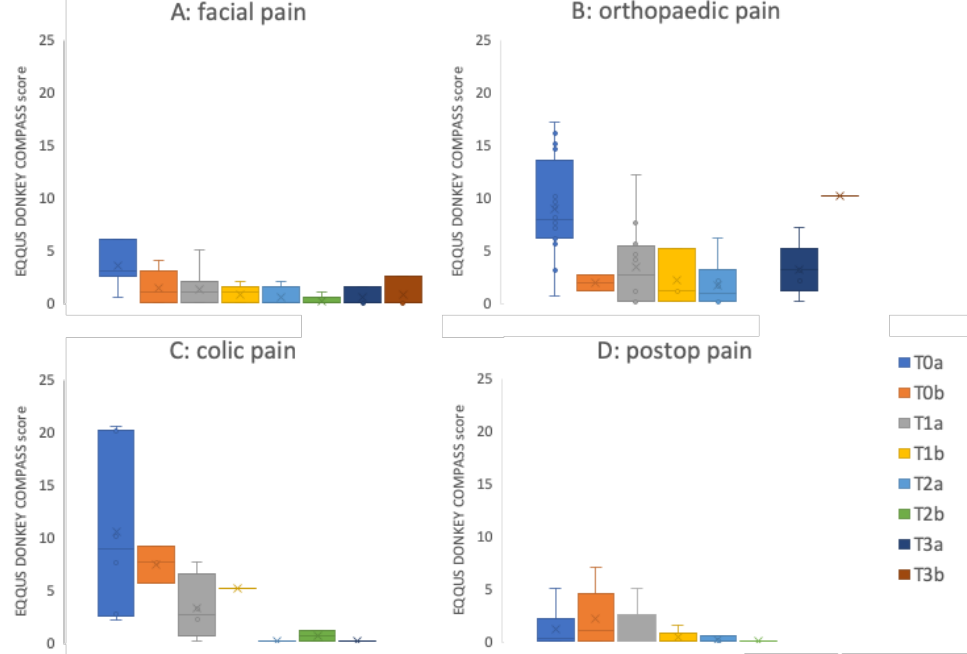
Figure 6. EQUUS-DONKEY-COMPASS mean patient scores over time. ( A ) Facial pain ( n patients on Day